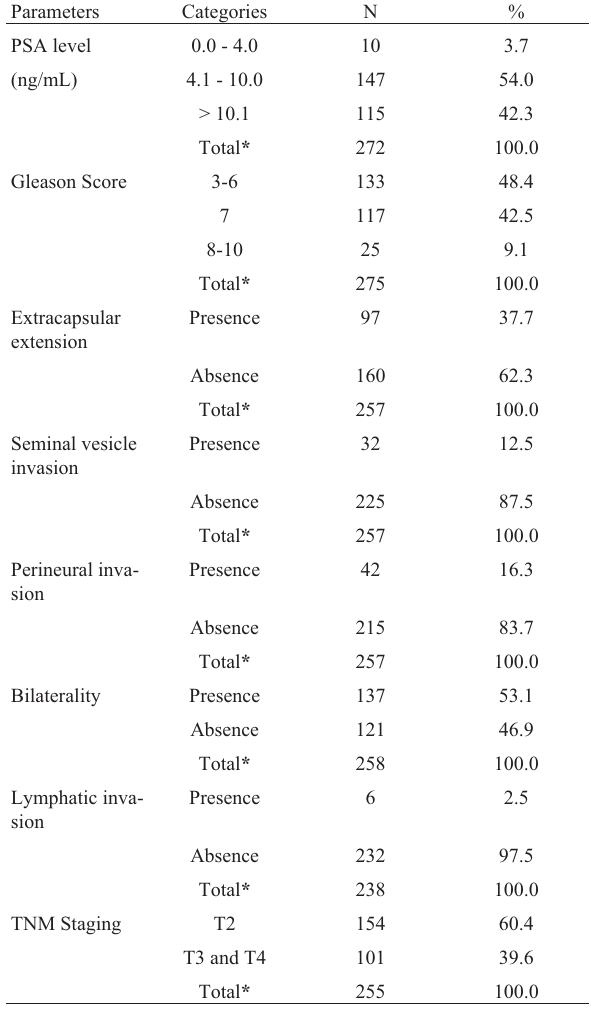
Table 4 - Analysis of PSA levels of prostate cancer patients and histo- pathological characteristics of the tumors.